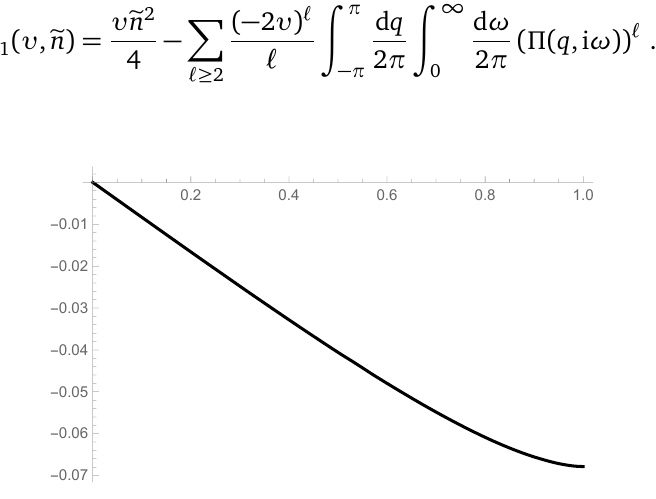
( n ) in (14) as a function of 0 ≤ n ≤ 2